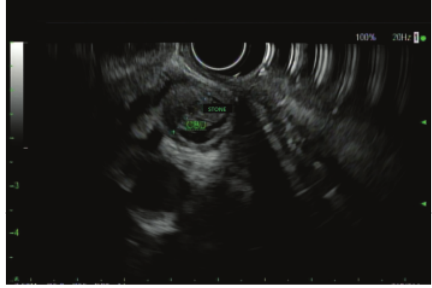
Figure 2: Upper endoscopic ultrasound.